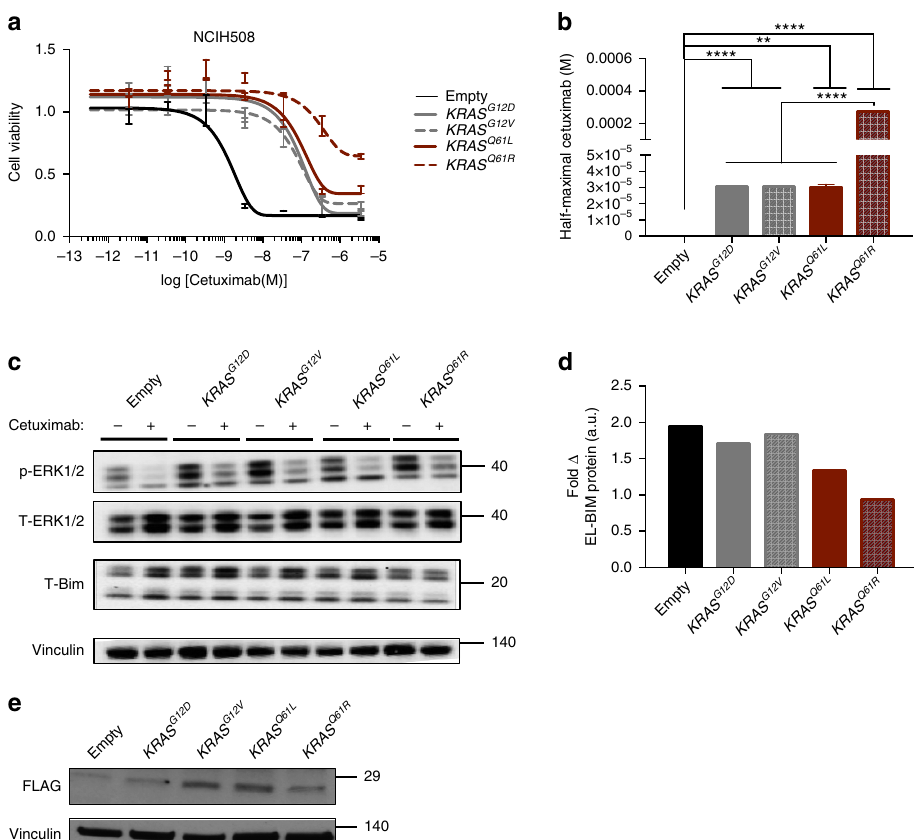
Figure 4 | Model of clinical KRAS -mediated resistance to cetuximab reveals selection of more potent KRAS mutations. ( a ) Nonlinear regression growth curves depicting cell viability as detected by Cell Titer Glo of NCIH508 cells transduced with a vector encoding no transgene (empty) or the indicated RAS transgene in the presence of cetuximab. ( b ) Derived half-maximal growth inhibition values of curves in a . ( c ) Immunoblotting of indicated constructs for phospho- and total-ERK1/2 and T-BIM in NCIH508 cells. ( d ) Fold change in extra long BIM (EL-BIM) protein levels from the immunoblots in ( c ) comparing cetuximab and vehicle treated cells. ( e ) Immunoblotting of indicated constructs for FLAG-tagged KRAS. In all cases, data are average ± s.e.m. ( n ¼ 3 technical replicates per condition). Images are cropped for clarity. ** P r 0.01; **** P r 0.0001. P values were calculated with unpaired, two-tailed Student’s t